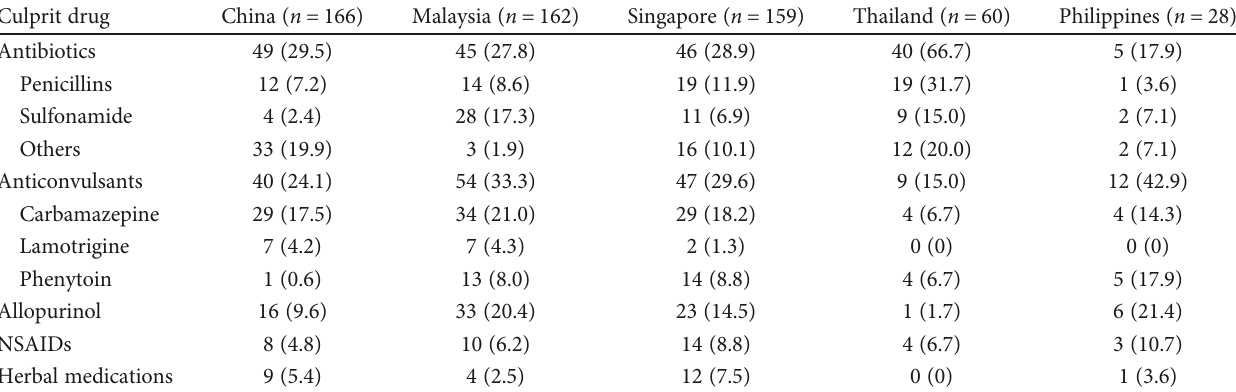
Table 4: The comparison of the common drug causality from cases in China with other populations in Southeast Asia ∗ .